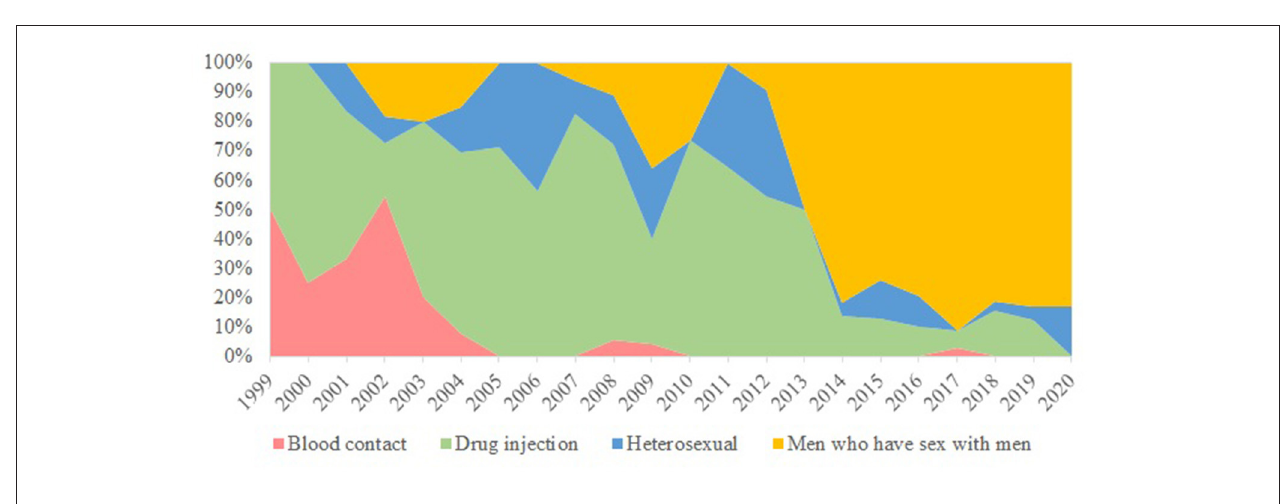
FIGURE 1 | Temporal trend of HCV infections by route of